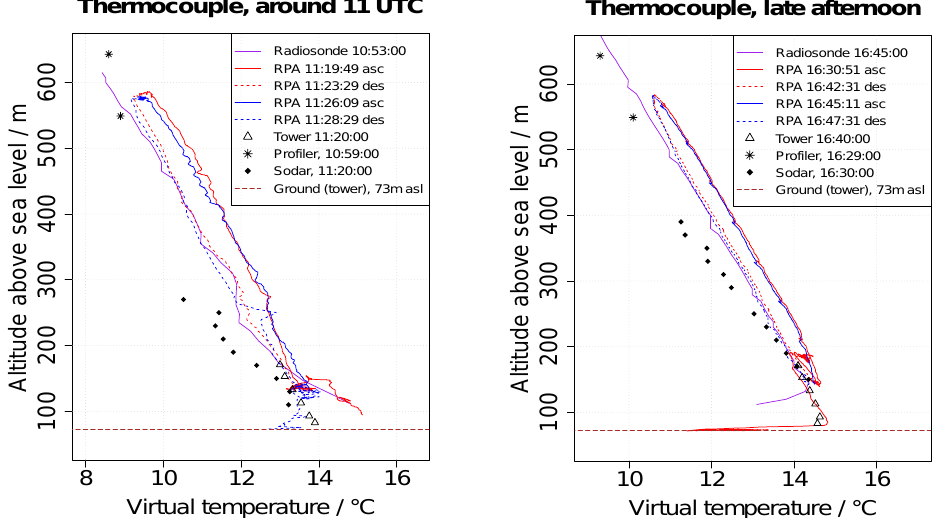
Fig. 11. Comparison of thermocouple on the RPA with remote sensing and tower data for vertical profile flights on Sunday, 23 September 2012.